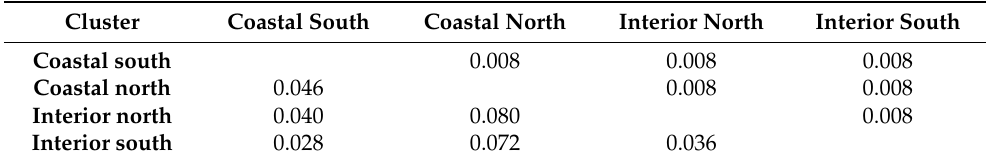
Table 2. Pairwise F ST values (below diagonal) between clusters for the K = 4 clustering solution (according to the STRUCTURE analysis) and probability of random F ST value being higher than the observed (above diagonal). The indicative adjusted nominal level (5%) for multiple comparisons is 0.008.